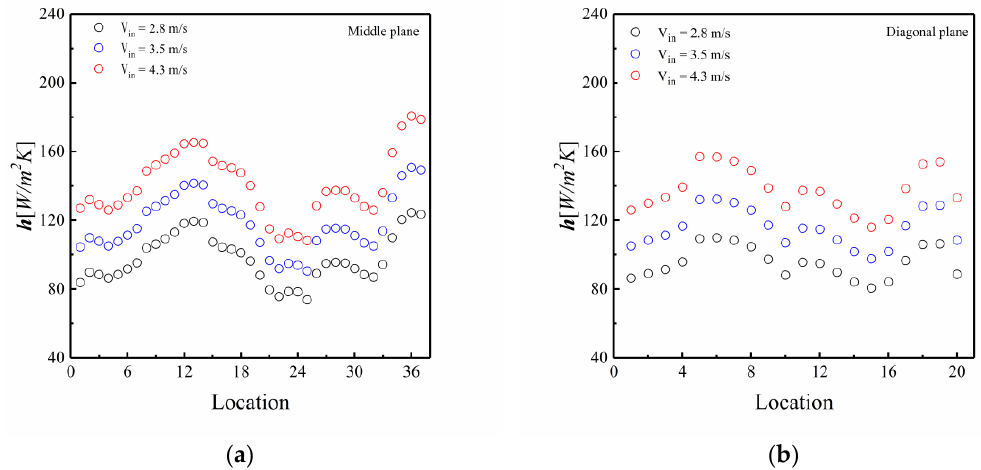
Figure 10. Local HTCs of three other cases in ( a ) the middle plane and ( b ) the diagonal plane.